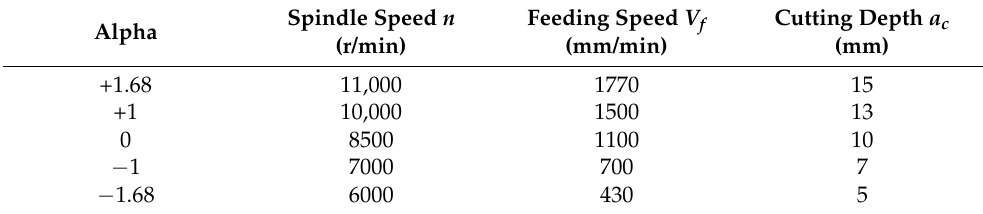
Table 2. Factors and levels of the CCD